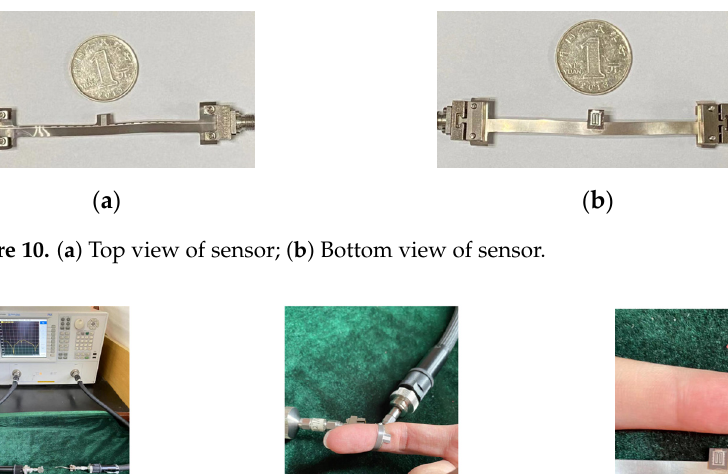
Figure 13. Measurement results when sensor is loaded with MUT with different dielectric properties. An experiment simulating the detection of abnormal skin tissue was performed. As shown in Figure 14, pork skin was used as the model for human skin because of its dielectric properties that are similar to human skin. Abnormal tissue mimicking phantom materials was made to mimic abnormal tissues with high water content (such as malignant skin, inflammatory skin, etc.) and it was embedded into the pork skin as abnormal skin tissues [47,48]. A lateral measurement which was carried out in a one- dimensional direction was performed and the result is shown in Figure 15. As shown in Figure 15, the motion resolution was 1.25 mm and the abnormal tissue can be clearly identified. Furthermore, another measurement which was carried out in a two- dimensional direction was performed. The motion resolution of the sensor was set to 2.5 × 2.5 mm 2 for the convenience of measurement. As shown in Figure 16a,b, the position with dark color represents the position with high permittivity and high loss tangent, which means the water content was high. The deepest color in the middle of the images corresponds to the abnormal tissue of the skin, and therefore the abnormal tissue can be roughly distinguished. This experiment showed that the designed sensor can detect skin abnormalities.